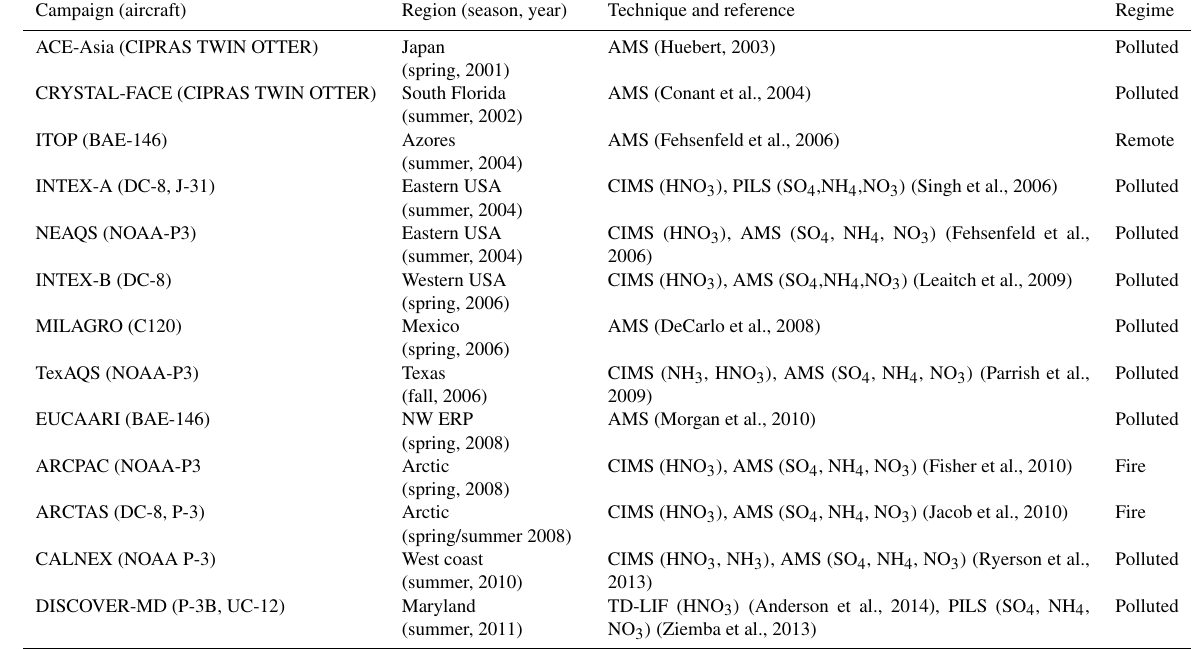
Table 2. Airborne measurements used in this study. Campaign (aircraft) Region (season, year) Technique and